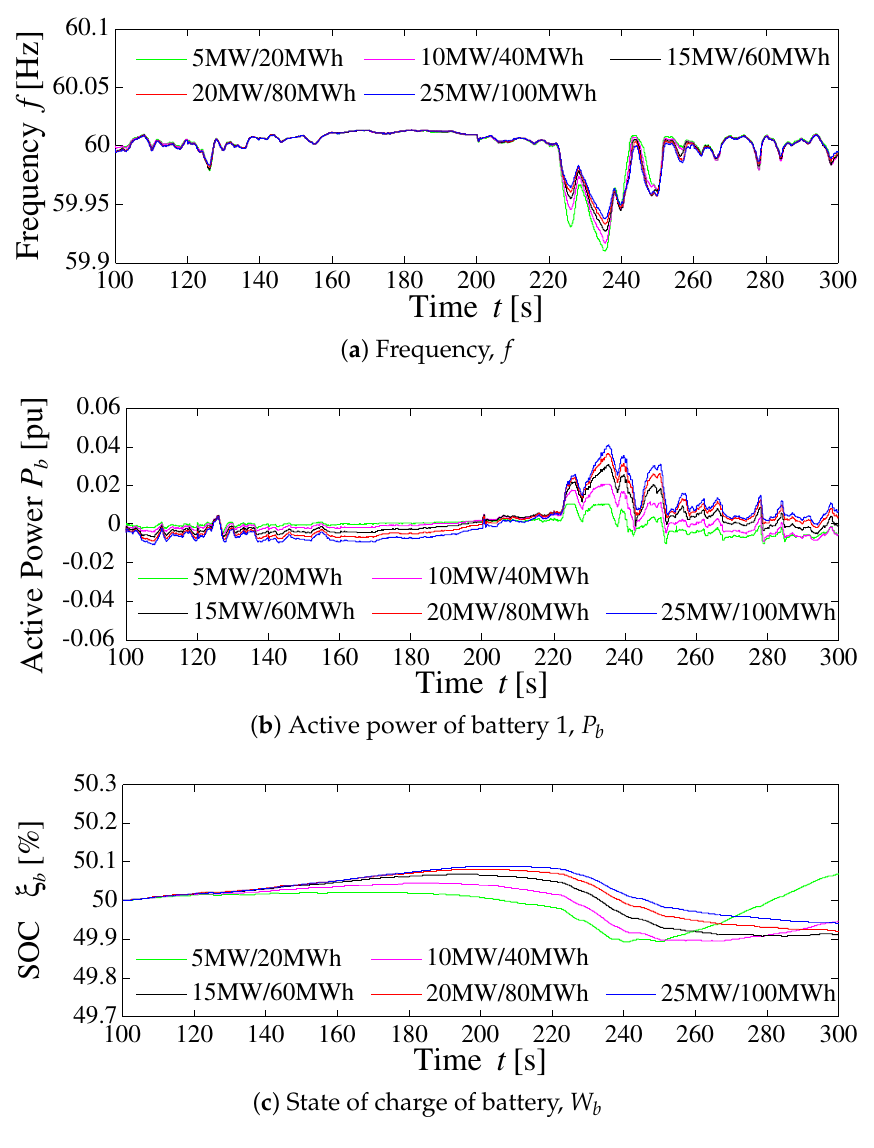
Figure 19. Simulation result for comparison of installed capacities of battery (with battery, supply power suppression of renewable energy source and demand